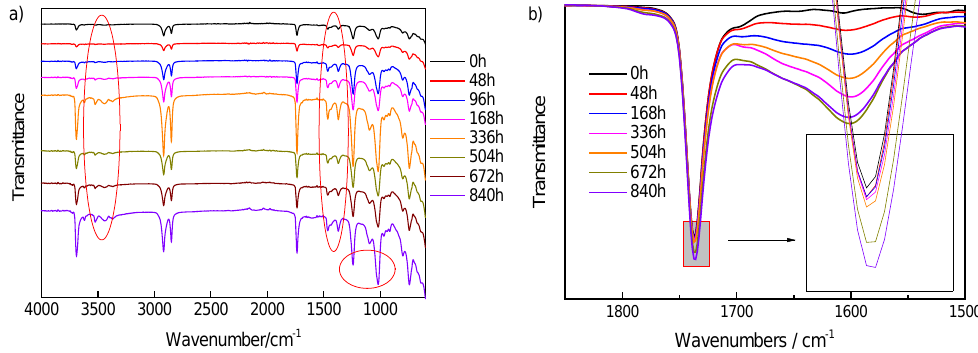
Figure 1. The absorption spectrum of Fourier transform infrared (FTIR) spectroscopy of the samples at different aging stages, a ) was the absorption spectrum from 4000 to 1500 cm − 1 and b ) was the smaller step size scanning in the range of 2000–1500 cm − 1.